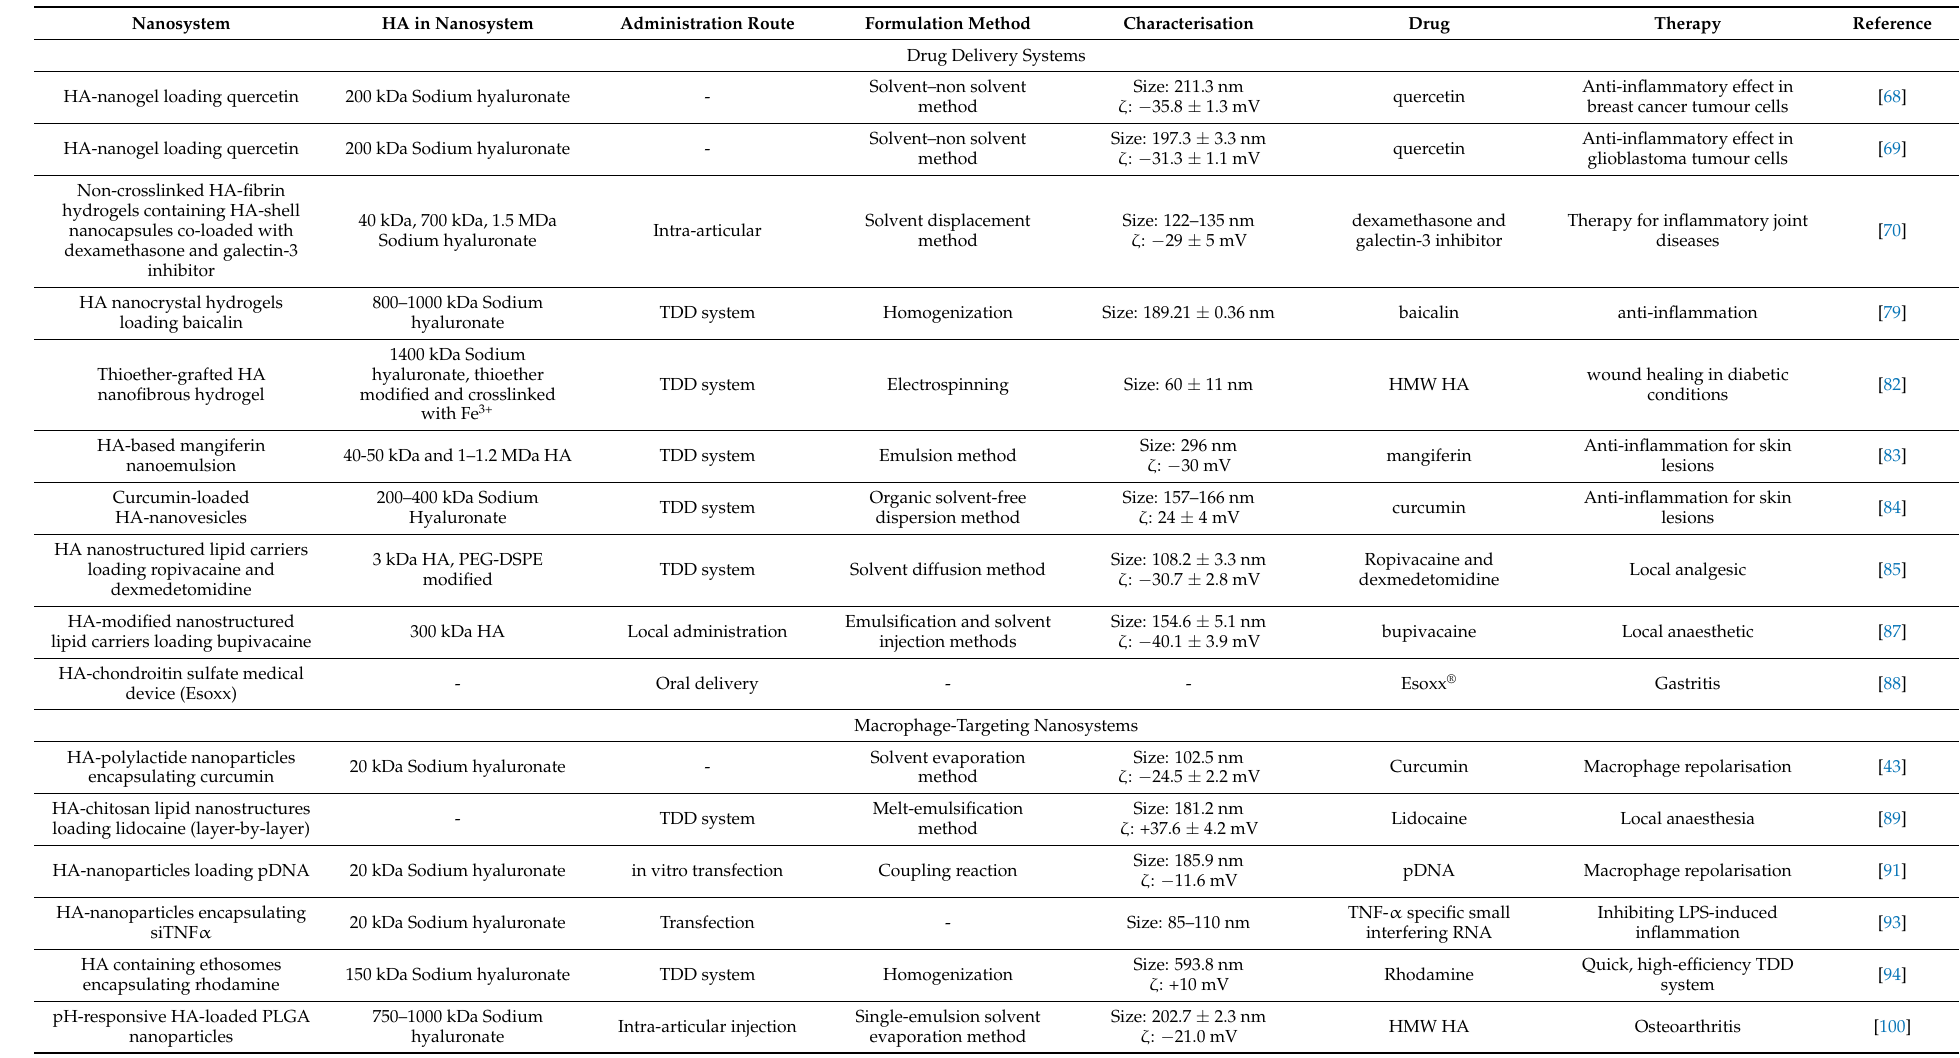
Table 1. Summary of HA-based nanosystems discussed in the